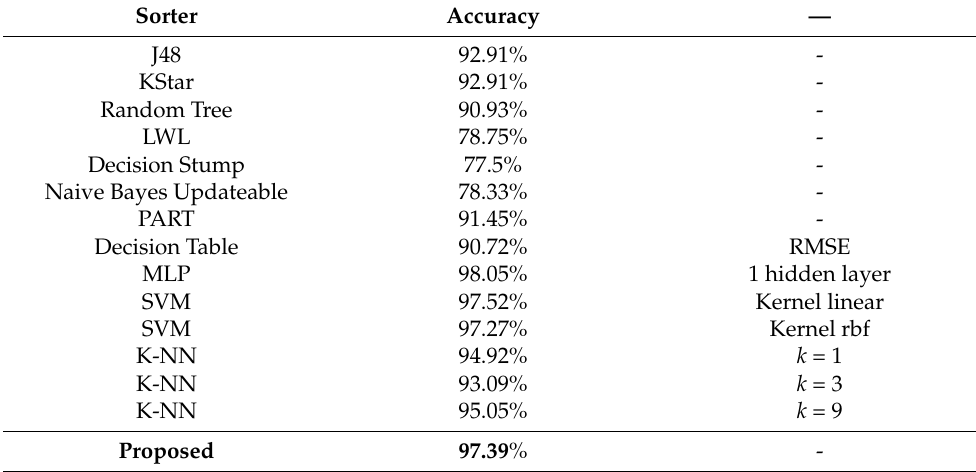
Table 3. Lesion type classification results: late blight, tomato mosaic virus and Septoria leaf spot.